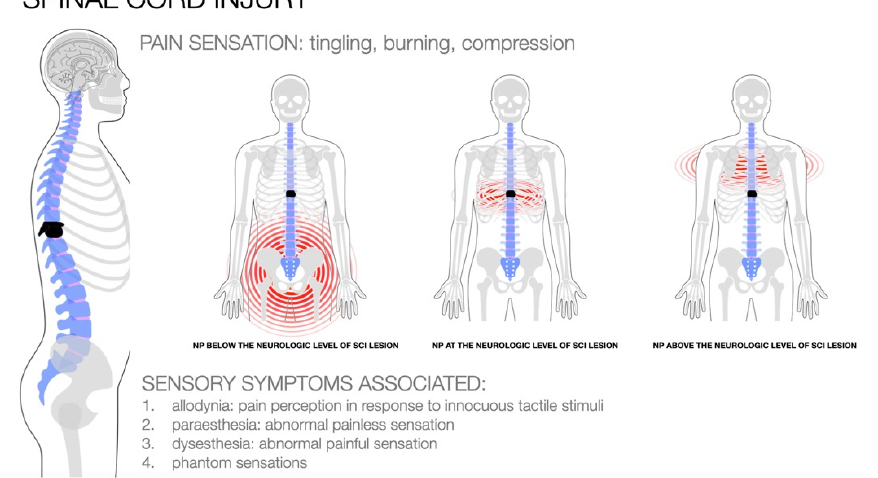
Figure 1. Clinical aspects of neuropathic pain following spinal cord injury. NP within the dermatome of the neurological injury and up to three levels below the neurological injury level, diffusely more than three dermatomes below the level of the neurological lesion.